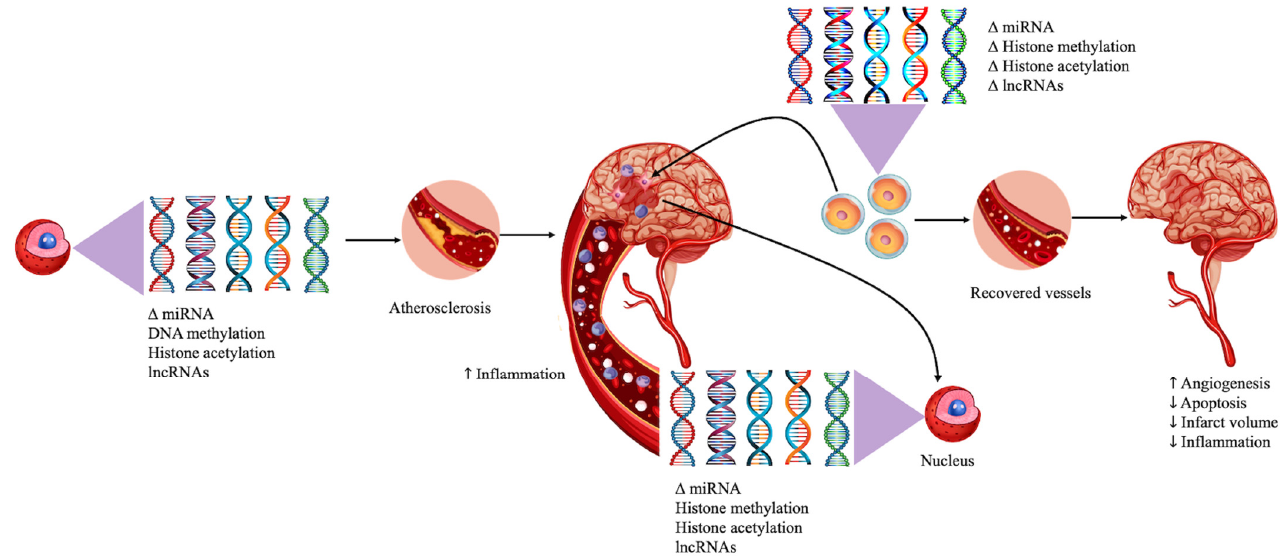
Figure 1. Epigenetic effects on atherosclerosis and neuroinflammation. This figure exemplifies the role of epigenetic modifications in promoting atherosclerosis, increasing the risk of stroke. It also illustrates how stroke can modify epigenetics worsening neuroinflammation. Stem cells have been shown to reverse these changes by increasing angiogenesis and decreasing inflammation, infarct volume, and apoptosis.